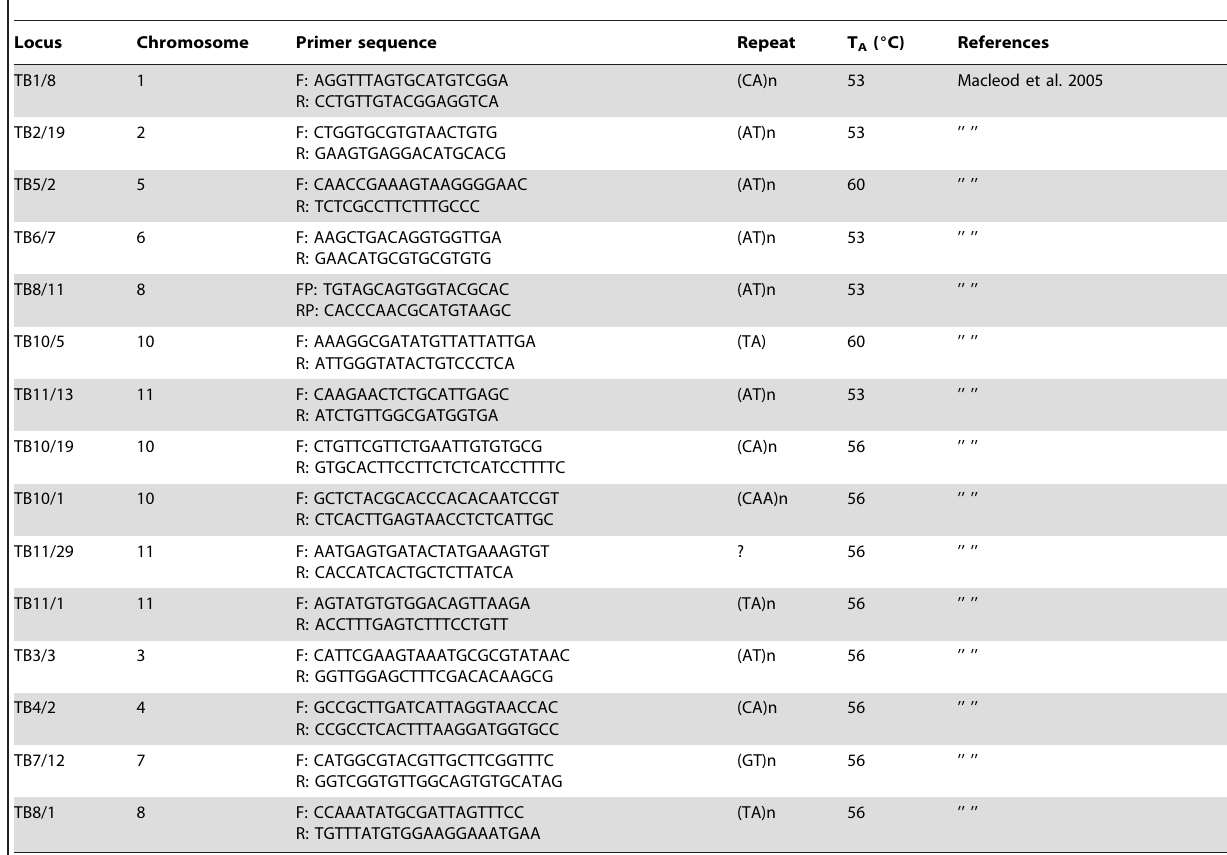
Table 2. Primer sequences used for amplification of microsatellite loci.